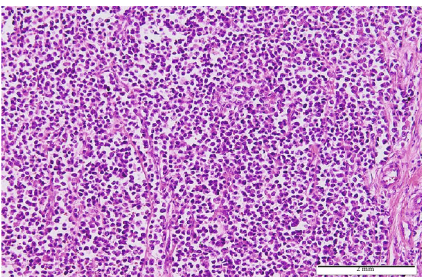
Figure 1: MRI of the left foot showing a large exophytic soft tissue mass in the medial side with necrotic center. The lesion involves the fl exor hallucis longus and the abductor hallucis muscles.